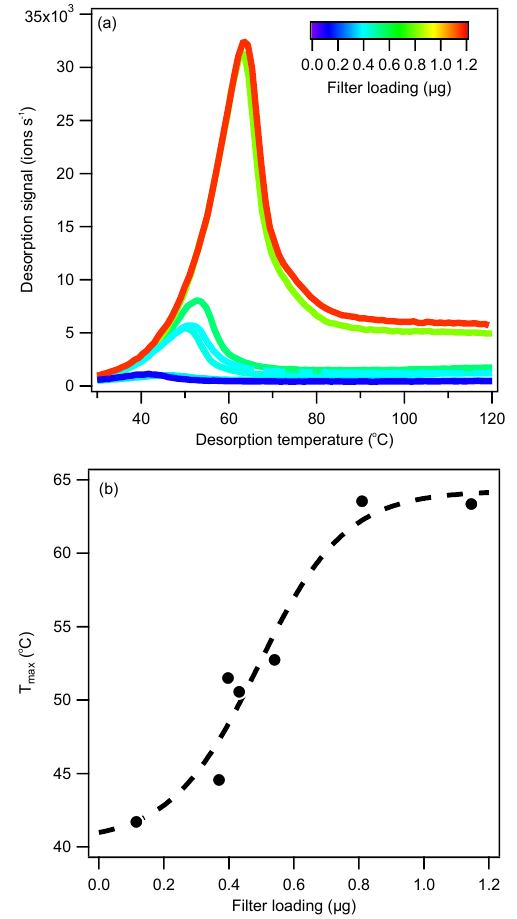
Figure 6. (a) The 1-D thermograms for levoglucosan (C 6 H 10 O 5 ) at different loading conditions and (b) the correlation between filter loading and T max . Levoglucosan aerosol was generated by nebuliz- ing a 1.2 E − 2 M aqueous solution. The aerosol was injected into the clean Teflon chamber, collected onto the FIGAERO filter, and ana- lyzed. The T max -loading correlation for pure levoglucosan could be described by a sigmoid function, leveling off at 41 and 64 ◦ C under very low and very high loading conditions,